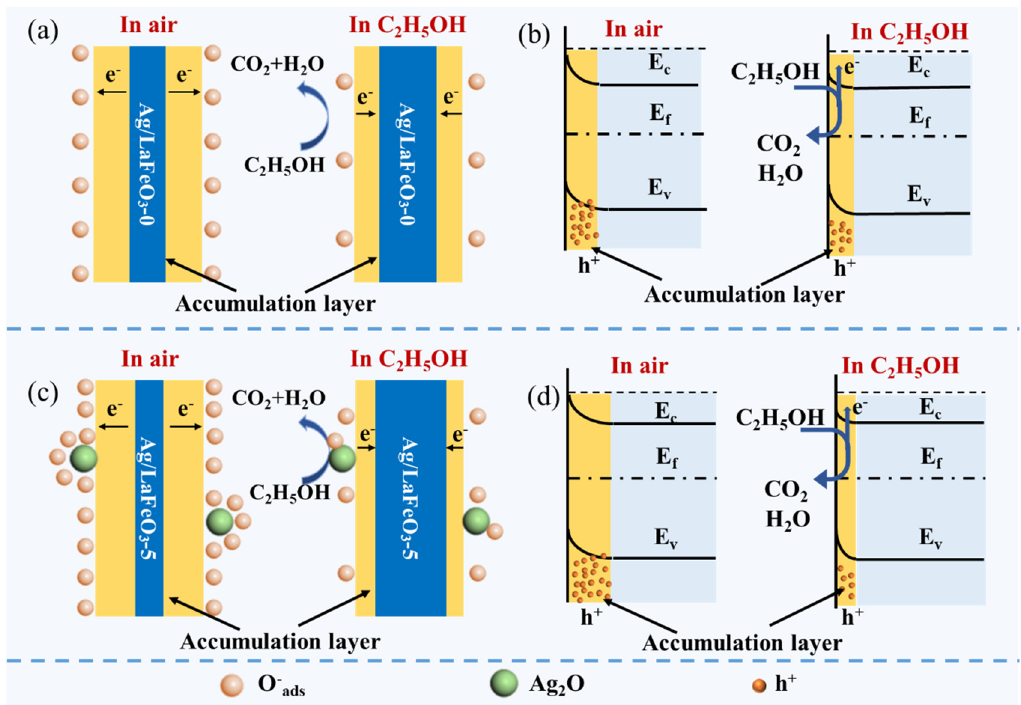
Figure 6. Schematic diagrams of the mechanism for the C 2 H 5 OH sensing on the ( a , b ) Ag/LaFeO 3 − 0 nanosheets; ( c , d ) Ag/LaFeO 3 − 5 nanosheets. nanosheets; ( c , d ) Ag/LaFeO 3 -5